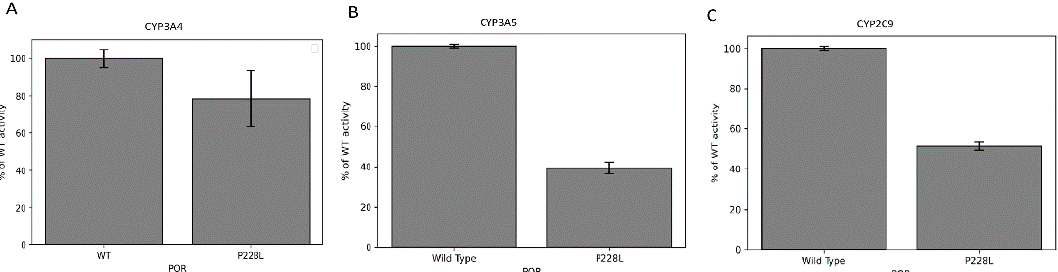
Figure 7. CYP3A4, CYP3A5, and CYP2C9 activity promoted by WT and P228L POR. Activity with the WT POR was set as a hundred percent, and results are shown as a percentage of WT activity. ( A ) In CYP3A4 assays, POR variant P228L had 79% of WT activity, while ( B ) in CYP3A5 assays, variant P228L had 41% of WT activity, and ( C ) in CYP2C9 assays, POR variant P228L had 52% of WT activity.